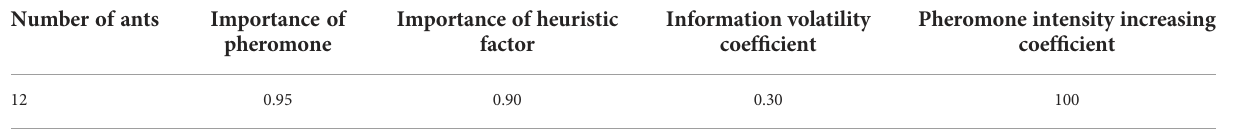
TABLE 2 Parameters of the ant colony